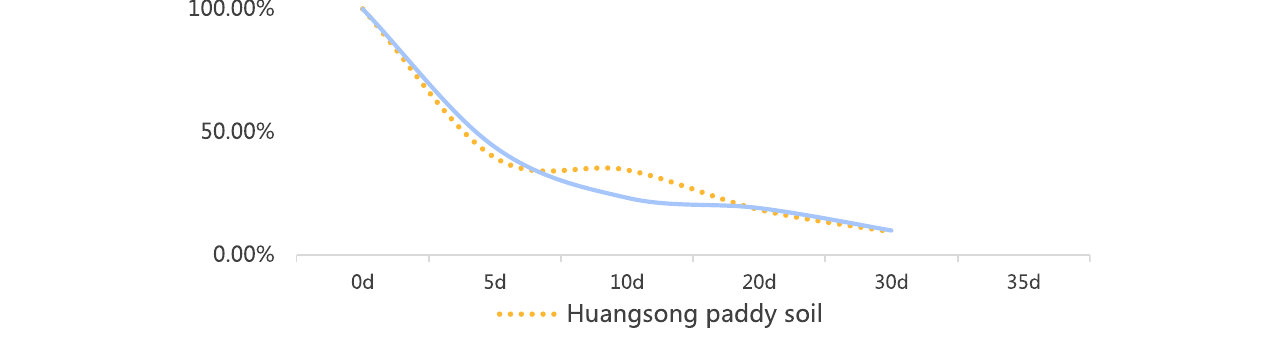
Table 3. Speci fi c radioactivity of Bt gene in soil accounted for amount of initial introduction